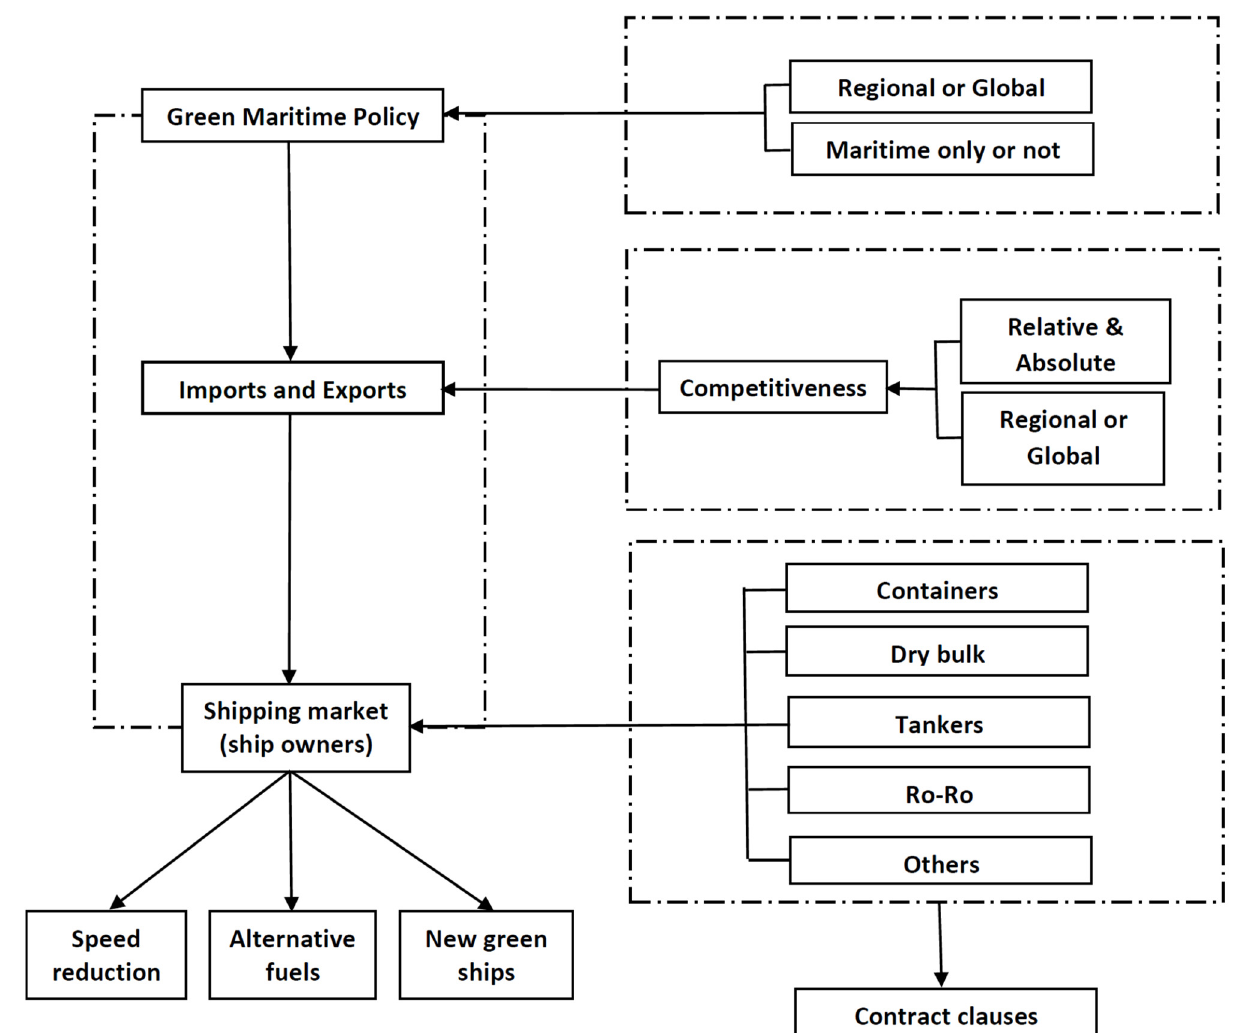
Figure 4. Factors that influence the costs for a ship owner.